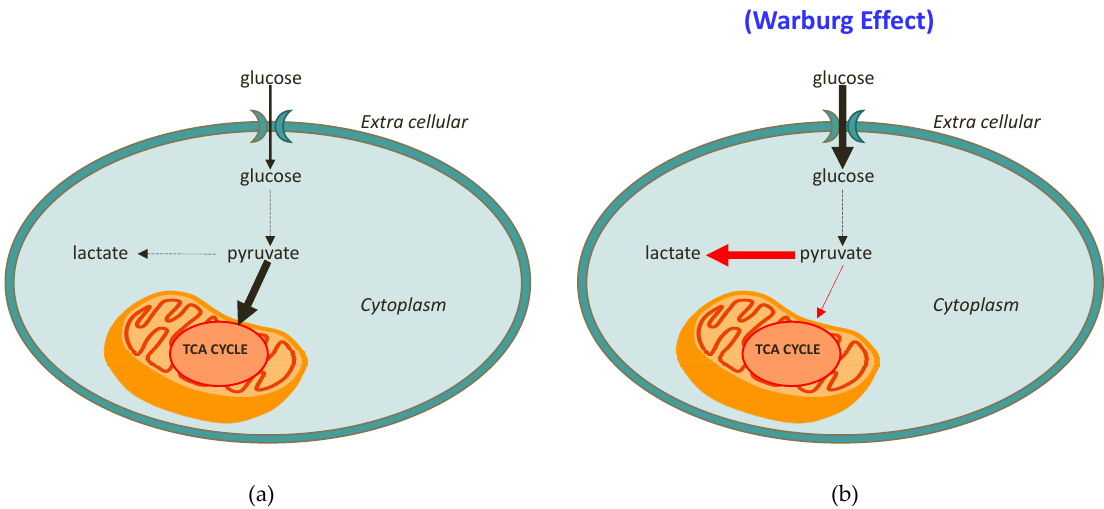
Figure 1. Schematic representation of ( a ) healthy cell metabolism in comparison to ( b ) cancer cell metabolism (the Warburg effect).